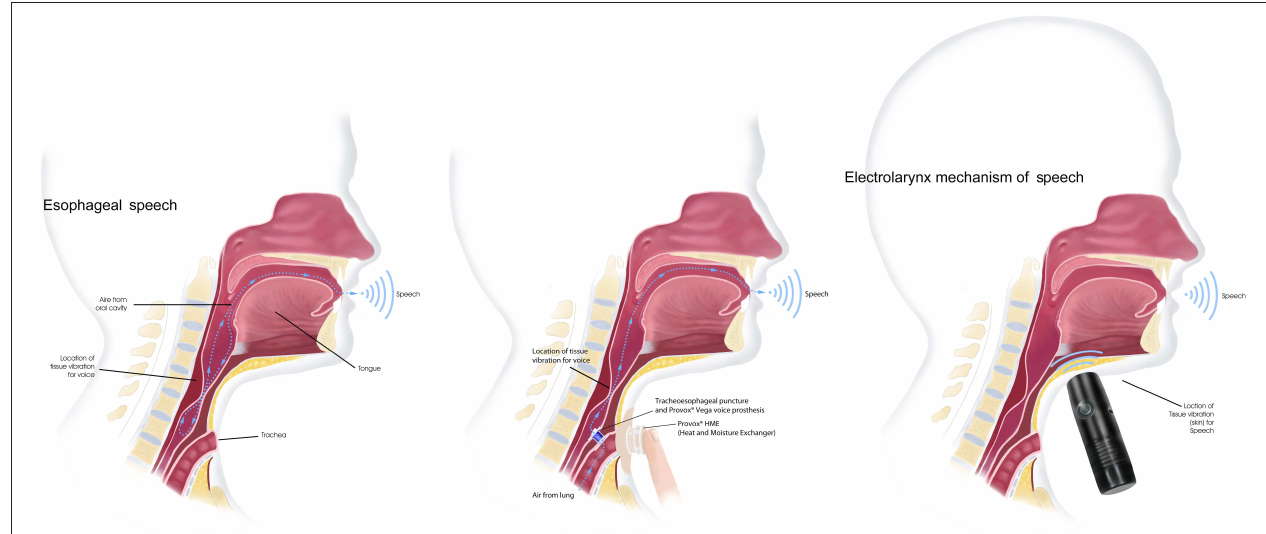
FIGURE 5 | Voice after a total laryngectomy. Vocal rehabilitation alternatives after total removal of the larynx Images courtesy of Atos